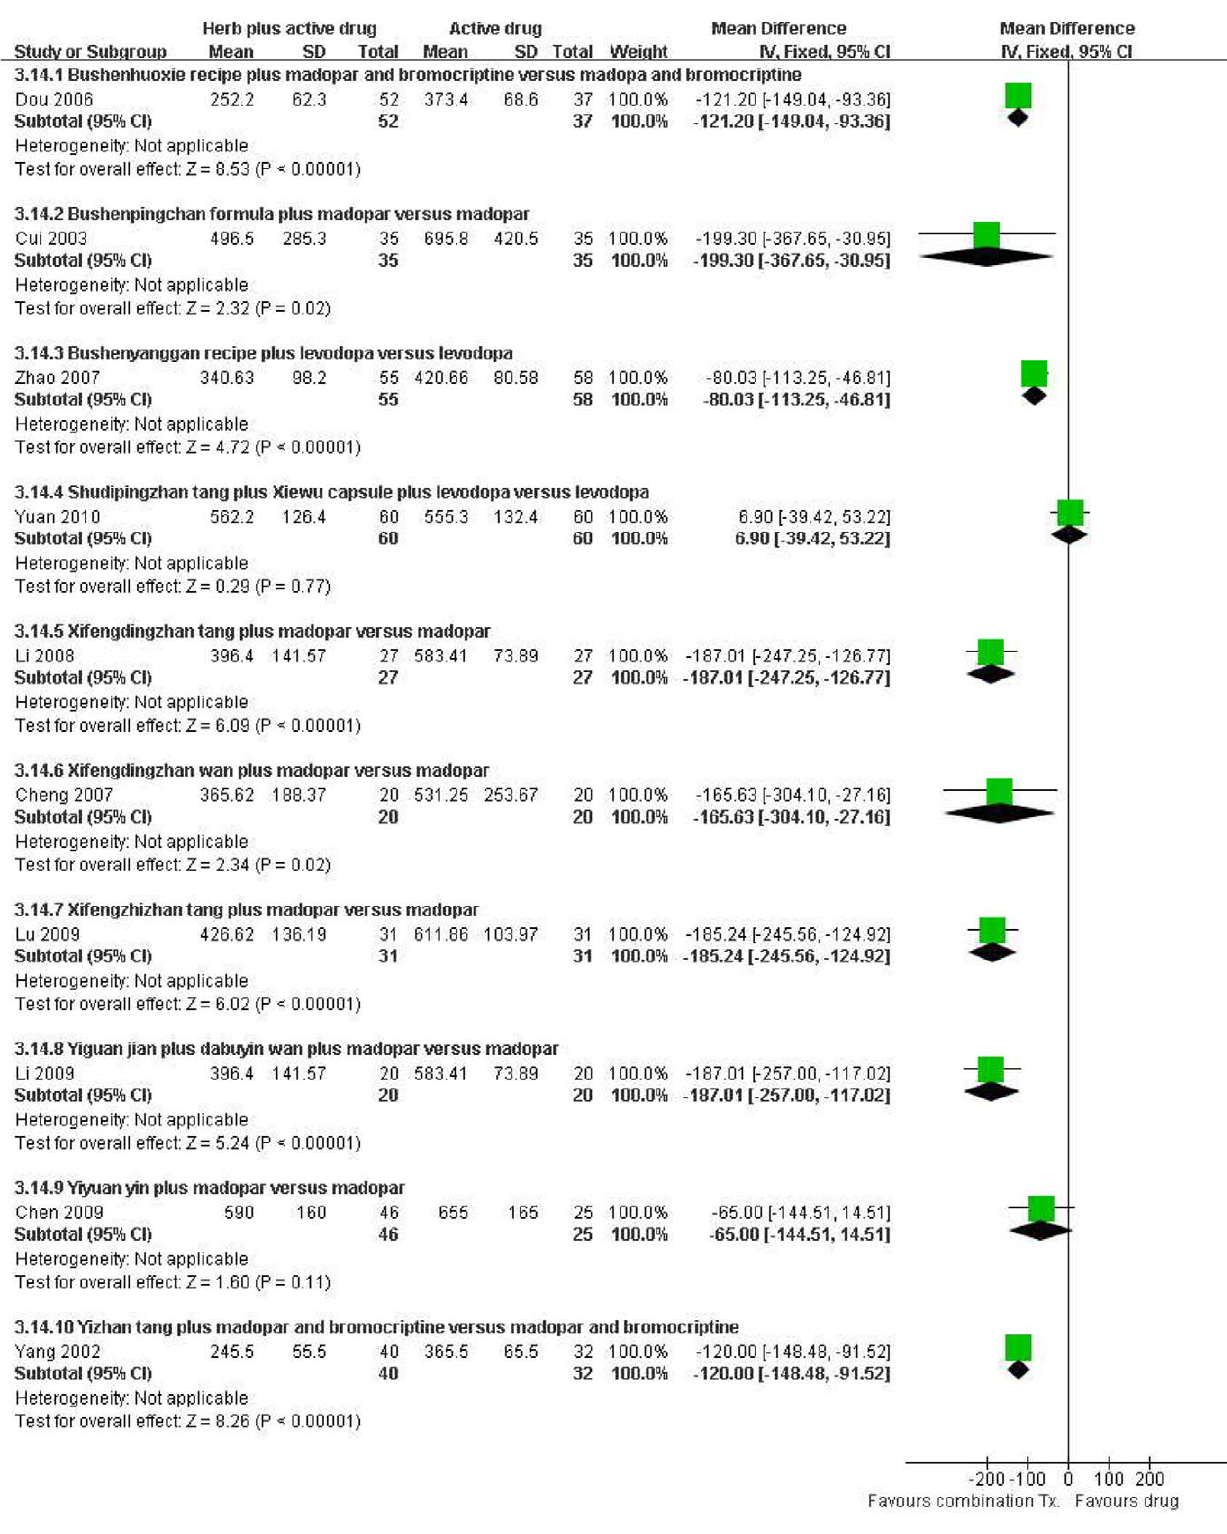
Figure 4. Herbal medicine plus active drug versus active drug, mean dose of levodopa (madopar).